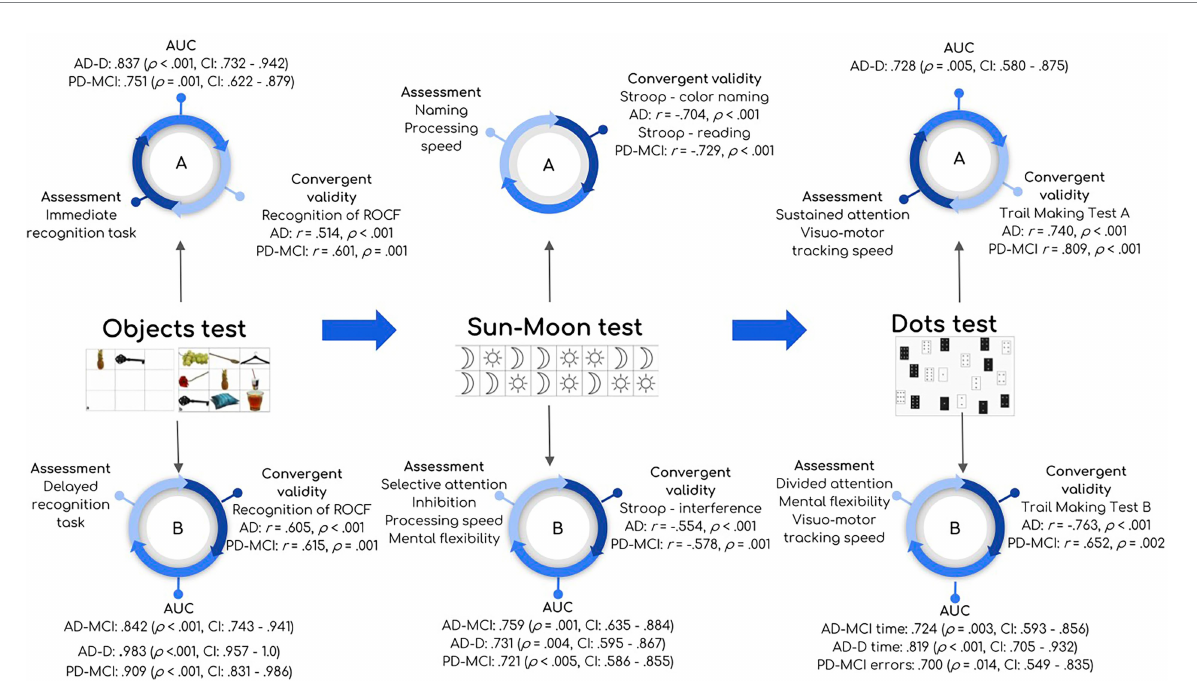
FIGURE 1 Summary of main results and characteristics of CCD. Figure shows part A and B of Objects test, Sun-Moon test, and Dots test. Each part (A and B) shows: cognitive process assessed (“Assessment”), ROC analysis for each clinical group (“AUC”) describing AUC (value of p , confidence interval), and correlations with standard tests (“Convergent validity”) describing r , value of p . ROC analysis was reported only in those cases with AUC > 0.70 and